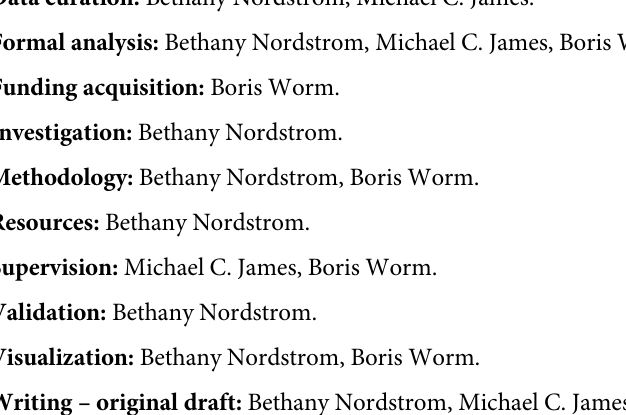
S1 Table. Spatial variations in mean SST in the study area. ‘St. Dev’ = standard deviation, ‘CI (95%)’ = confidence interval (95%). Atlantic Canada is the entire study region (Bay of Fundy, Scotian Shelf and Gulf of St. Lawrence combined). S2 Table. Two stage hurdle model comparison. Model selection shown in bold. SST = sea surface